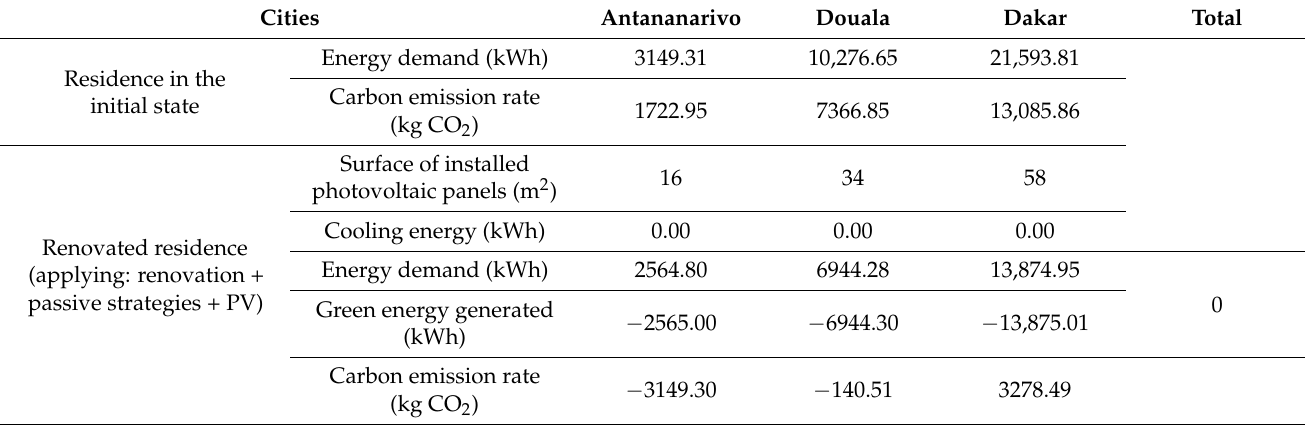
Table 7. Annual operational carbon and energy demand in the residential building of tropical regions. Cities